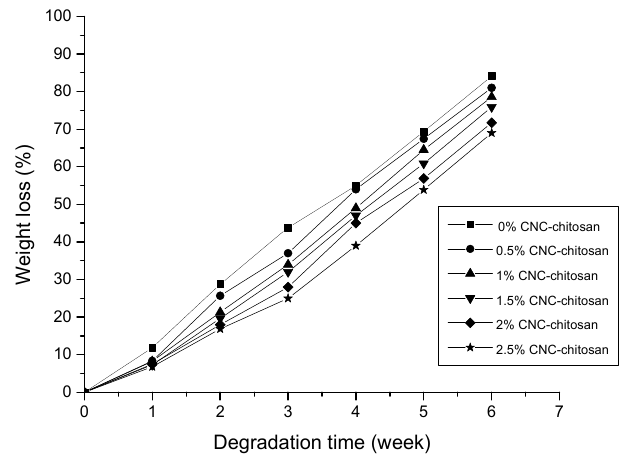
Figure 10. In vitro degradation study of the hydrogels.